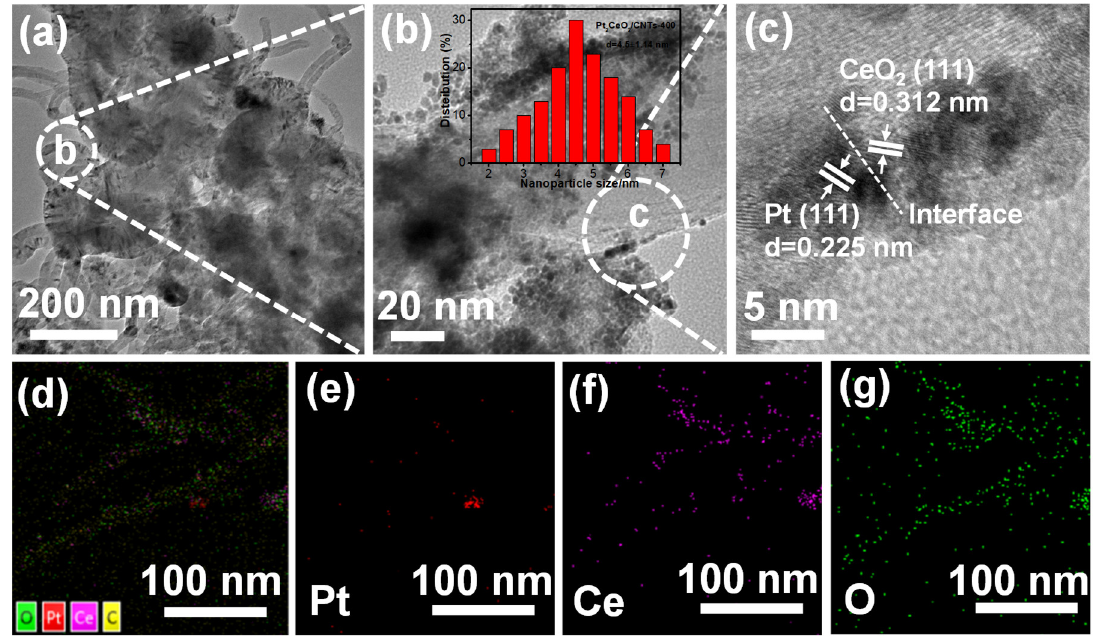
Figure 2. ( a ) TEM and ( b , c ) HRTEM images; the corresponding particle size distribution of Pt 2 CeO 2 /CNTs-400; ( d – g ) HAADF-STEM elements mapping; the corresponding elements Pt, Co and O of Pt 2 CeO 2